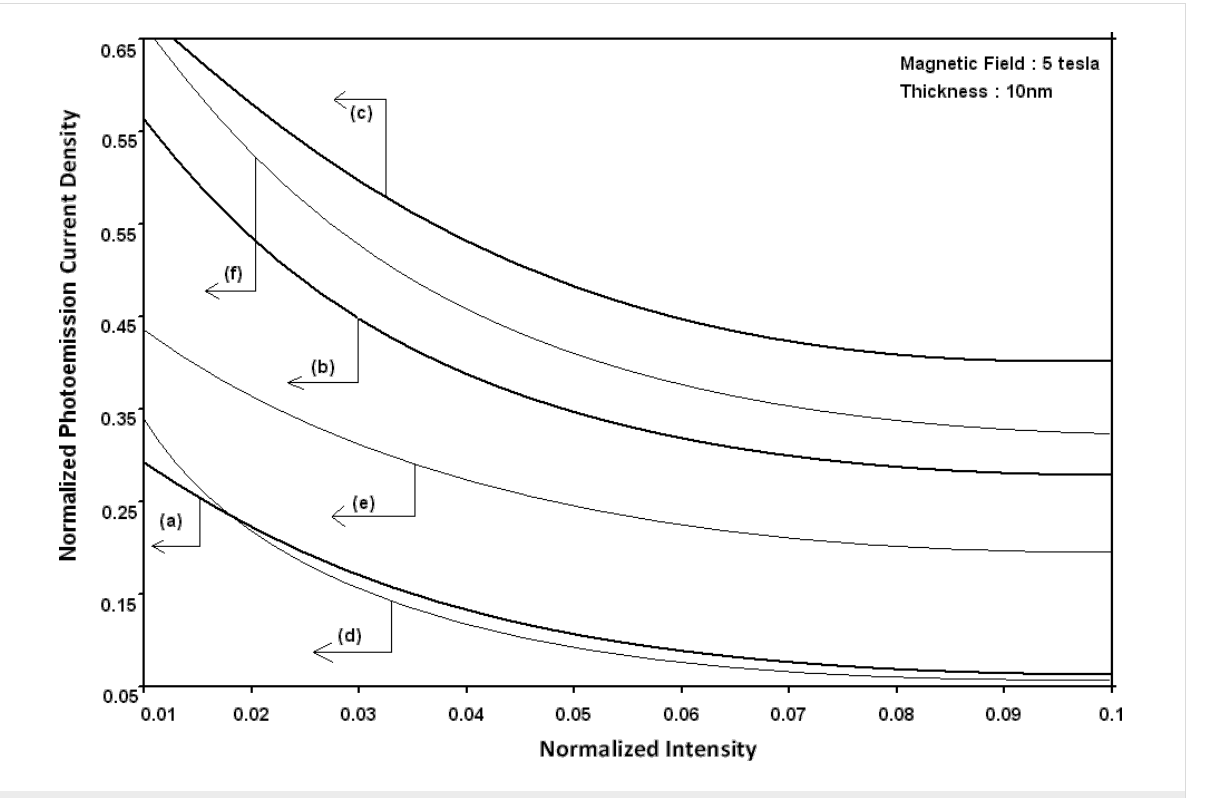
Figure 3: Plot of the normalized photoemission current density as a function of normalized light intensity for all cases of Figure